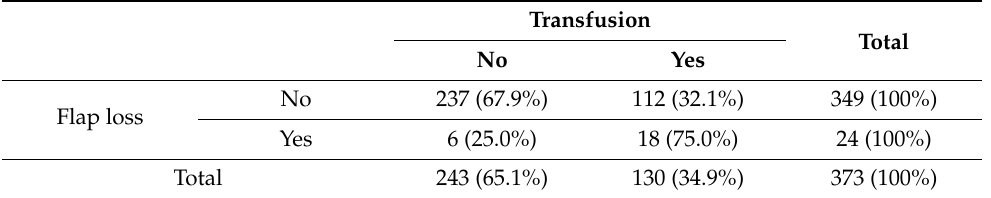
Table 4. Relationship between transfusion and flap